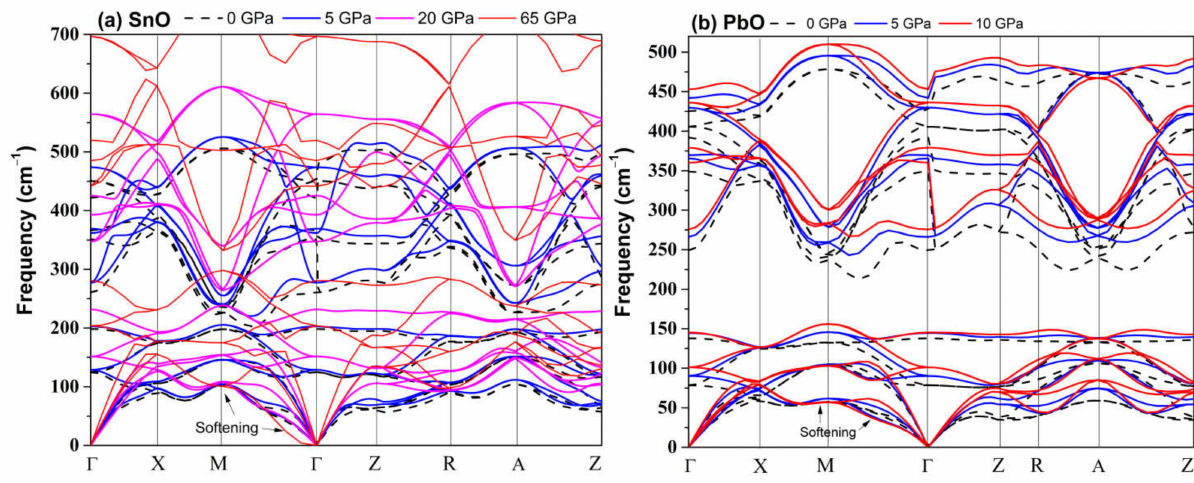
Figure 5. Calculated tetragonal P4/nmm phonon dispersion upon compression: ( a ) SnO; ( b )